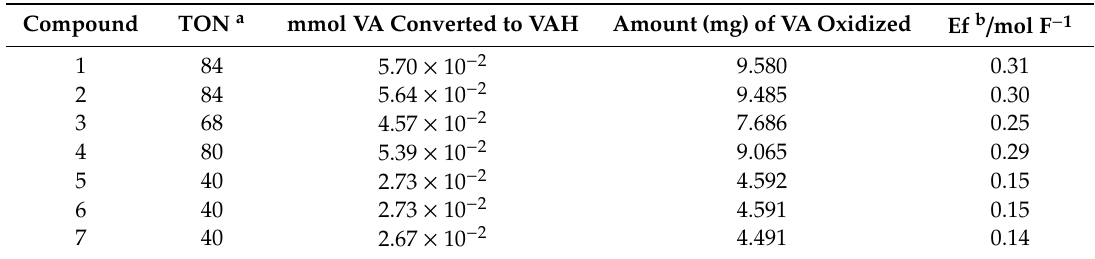
Table 1. Experimental conditions for the electrochemical conversion of VA to VAH (pH 8.25; 40 ◦ C; 4 V). Compound TON a mmol VA Converted to VAH Amount (mg) of VA Oxidized Ef b / mol F −